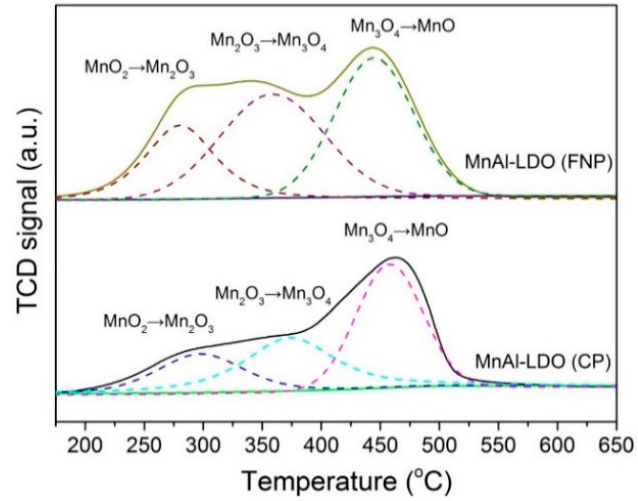
Figure 4. H 2 -TPR profiles of MnAl-LDO (CP) and MnAl-LDO (FNP) catalysts.